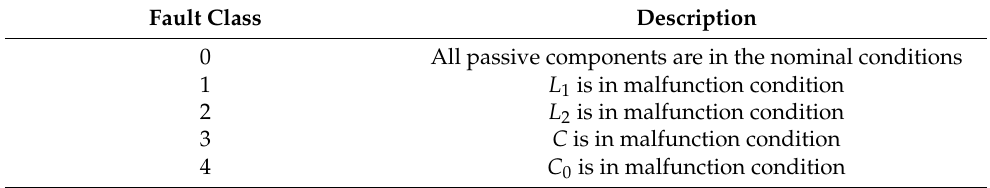
Table 4. Fault classes.